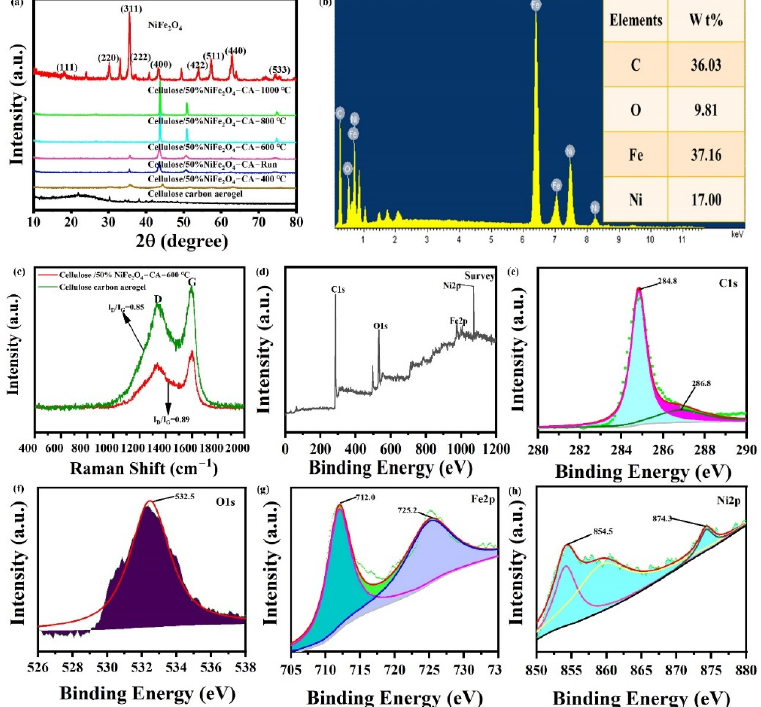
Figure 1. ( a ) XRD of different calcinated temperatures of cotton linters’ cellulose/NiFe 2 O 4 − CA − 600 °C; ( b ) EDS of cellulose/NiFe 2 O 4 − CA − 600 °C; ( c ) Raman spectrum of cellulose/NiFe 2 O 4 − CA − 600 °C and cellulose carbon aerogels; ( d – h ) XPS spectra of cotton linters’ cellulose/50%NiFe 2 O 4 − CA − 600 °C.